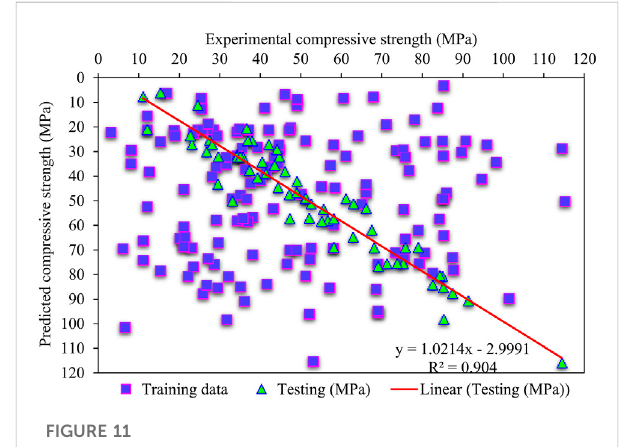
FIGURE 11 Adaboost predicted and experimental